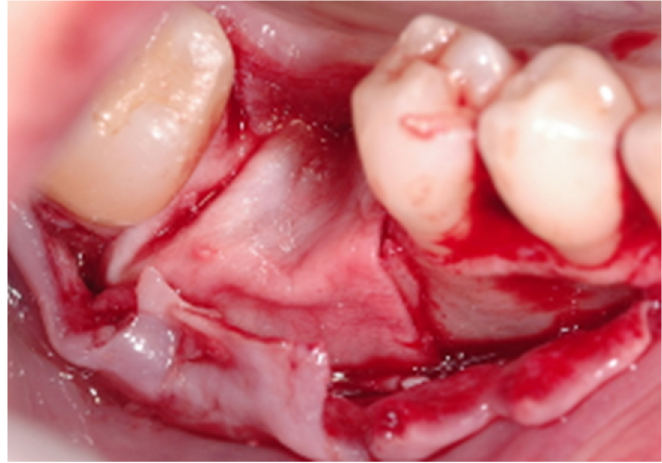
Figure 2. Filling the “box” with collagenated heterologous bone particulates.